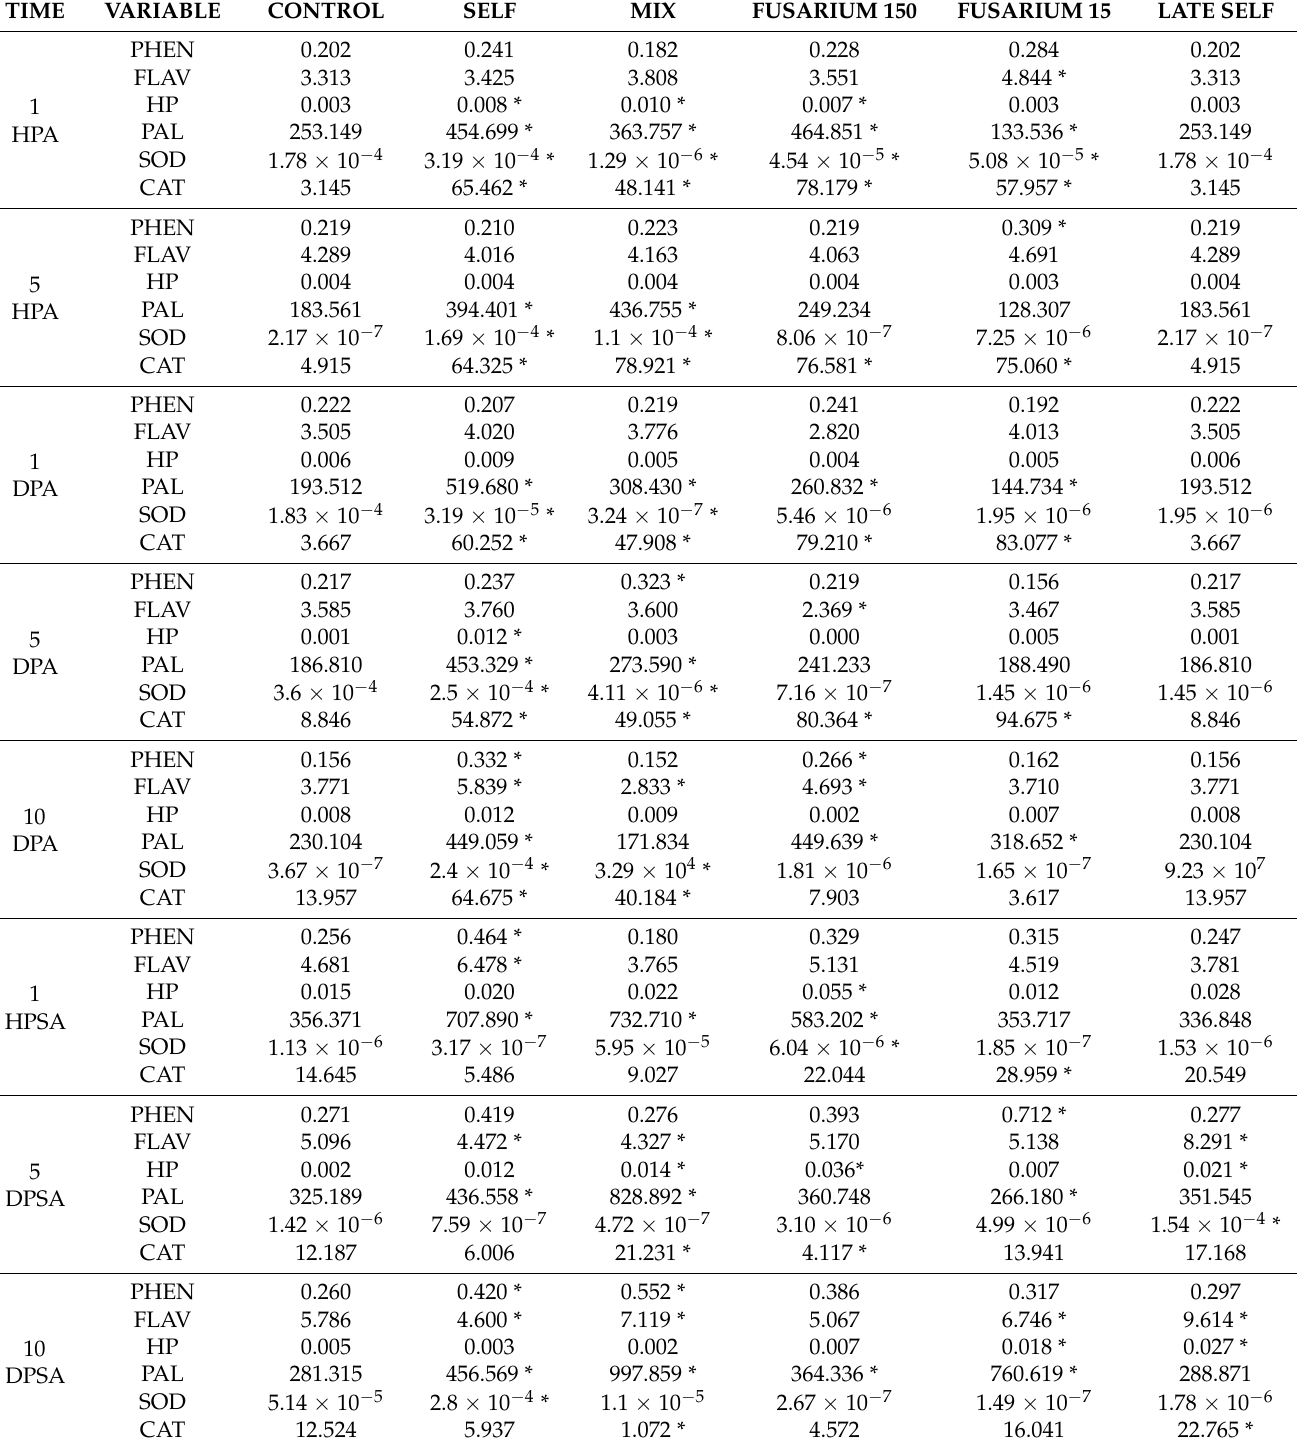
Table 2. Tomato immune responses to different eDNA